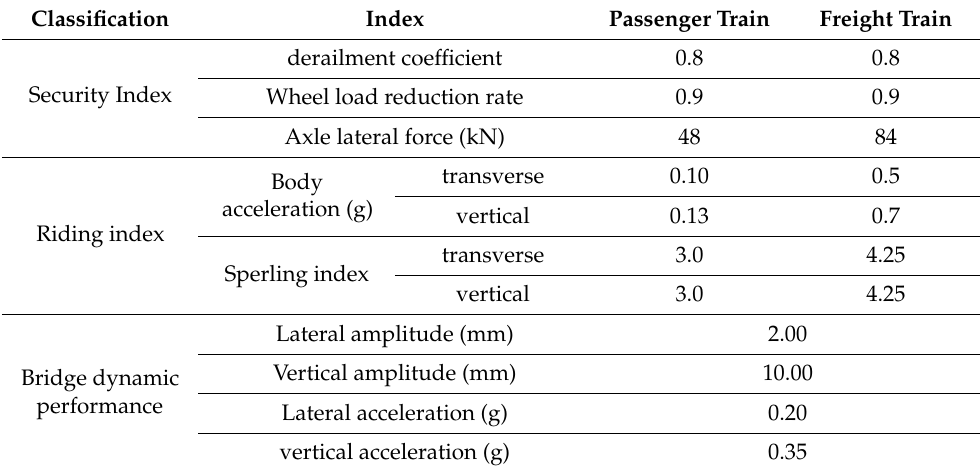
Table 5. Standard limits for dynamic performance evaluation of train-bridge